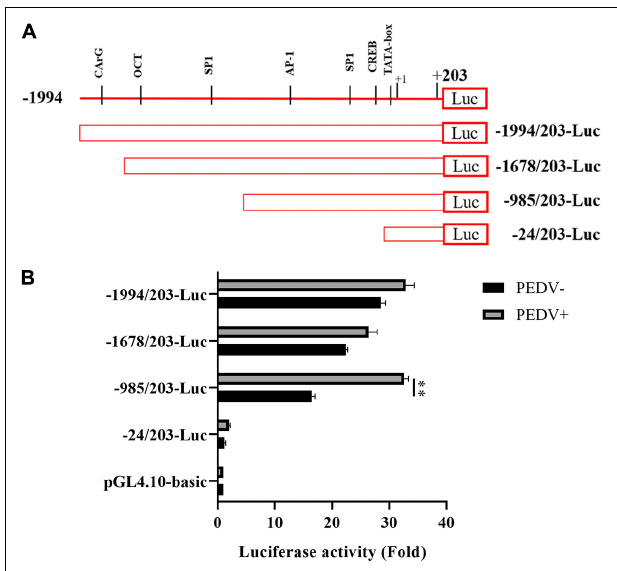
FIGURE 2 | Cell communication network factor 1 promoter sequences were cloned, analyzed, and mapped latent PEDV-responsive regulatory